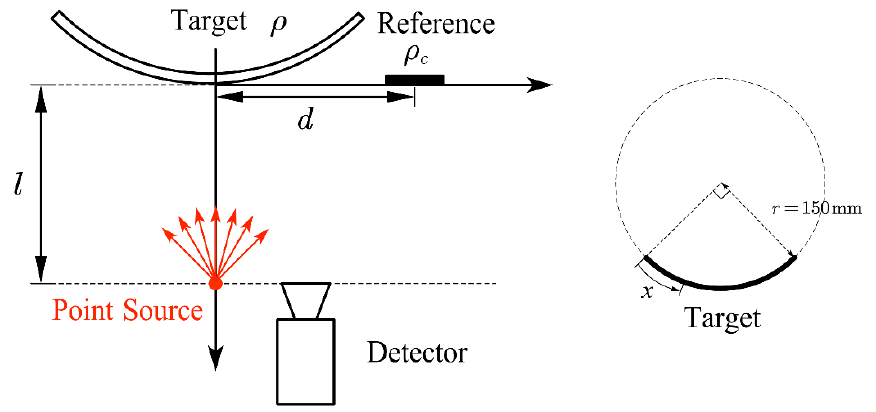
Figure 9. Schematic diagram of the measurement scene and curved surface target shape.